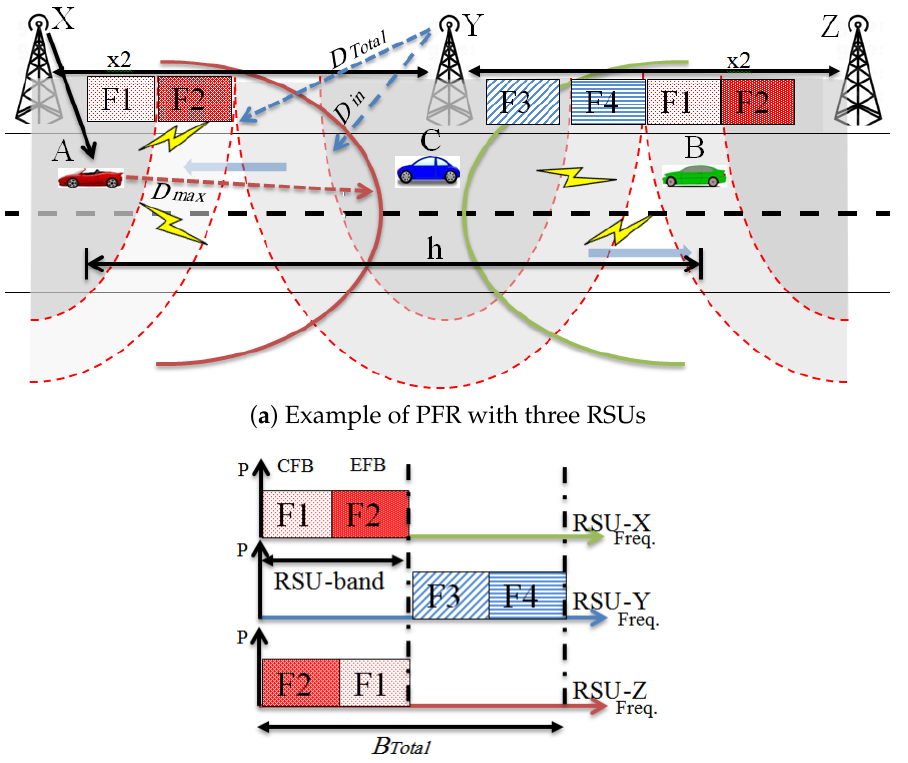
Figure 3. Example of PFR for three